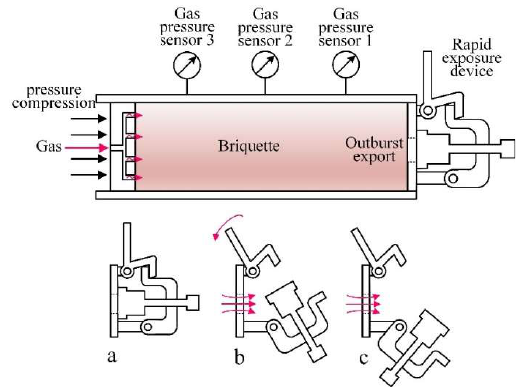
Figure 2. Coal and gas outburst simulation system: ( a ) initial state; ( b ) the opening process of the rapid exposure device; ( c ) the rapid exposure device is completely open.